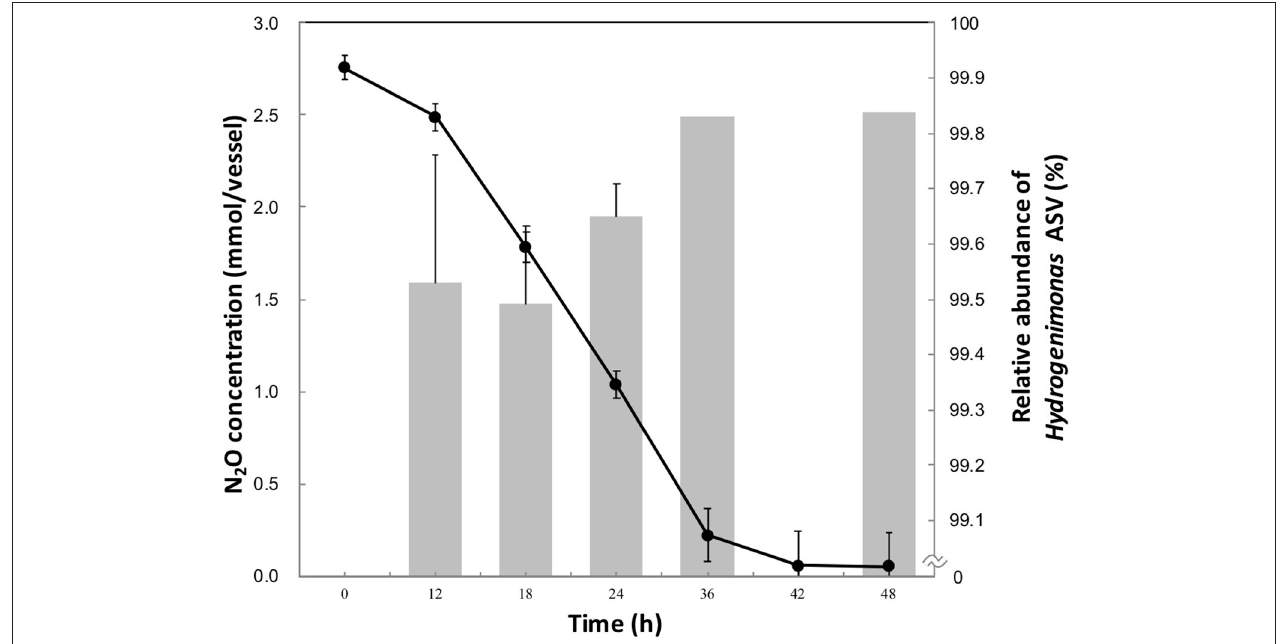
FIGURE 1 | N 2 O consumption (•) and relative abundance of Hydrogenimonas ASV in the enrichment culture (bar chart) during the 48 h-cultivation. The data points and error bars represent the means and standard errors, respectively.